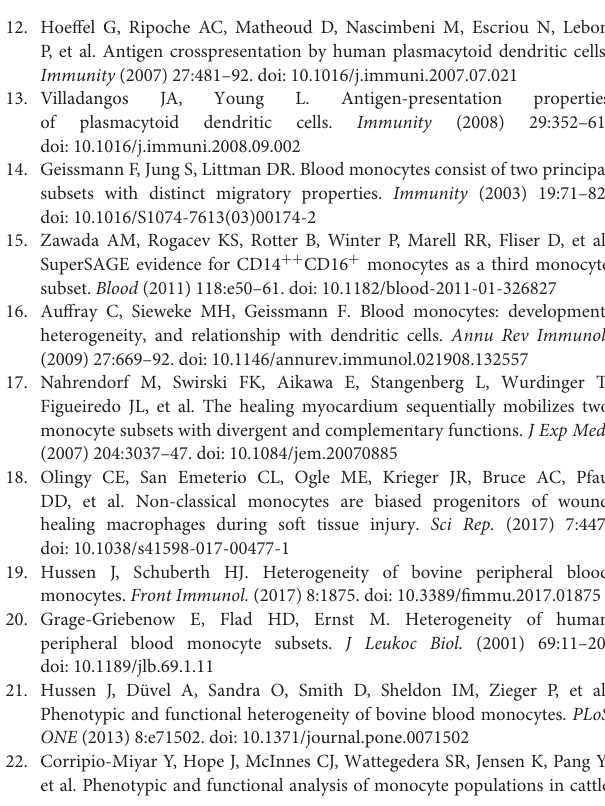
Supplementary File 2 | GO Term Enrichment Analysis cDC2 ′ vs. cDC2 ′′ . Supplementary File 3 | Subset-specific